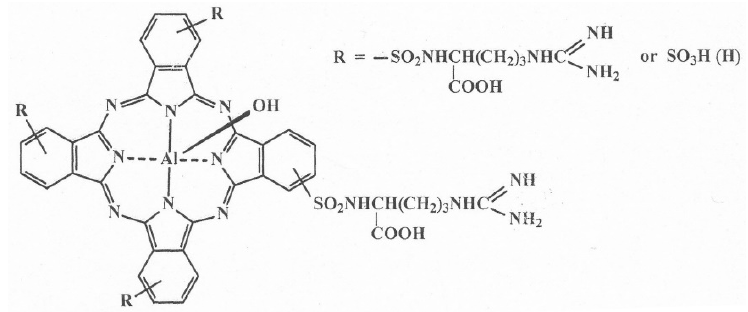
Figure 1. Structural formula of PS.